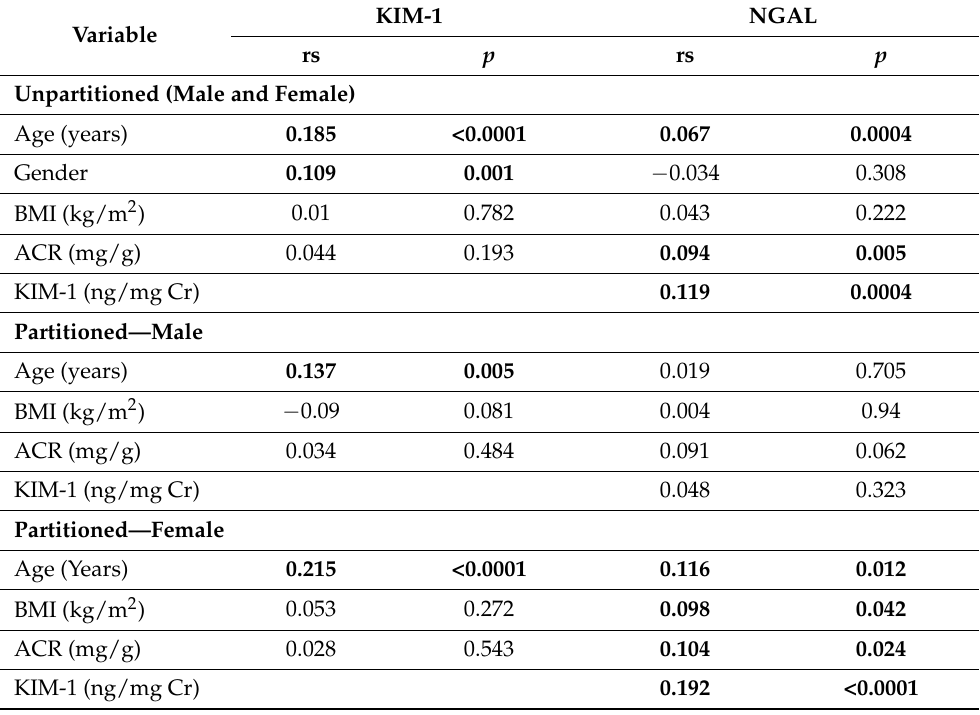
Table 3. Associations of creatinine-adjusted urinary KIM-1 and NGAL levels with age, gender, BMI, and ACR as expressed in terms of the Spearman correlation analysis. Significant associations are shown in bold. The Spearman correlation coefficient is denoted by rs, where p represents the probability. BMI: body mass index; ACR: albumin creatinine ratio. KIM-1 Variable